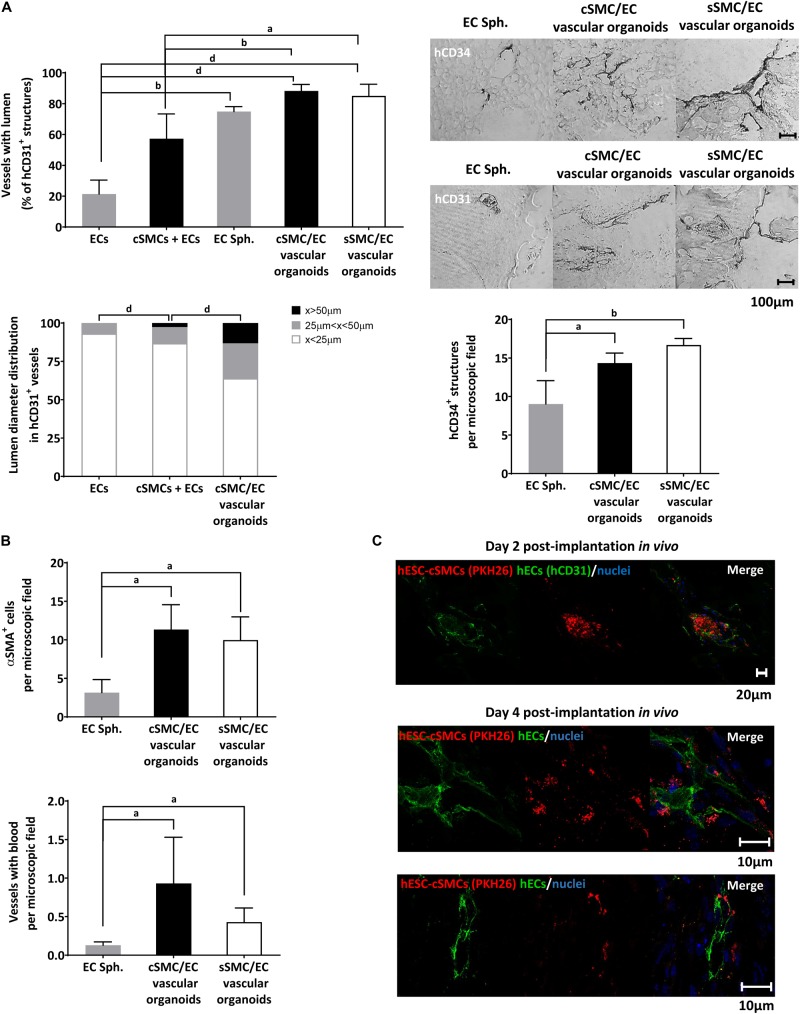
Functional characterization of vascular organoids in vivo.
(A) Chart presenting percentage of vessels of human origin (anti-hCD31 positive) with lumens in ECs, hESC-cSMCs + ECs single cell matrigel implants and in EC spheroids, hESC-cSMC/EC, hESC-sSMC/EC vascular organoid matrigel implants, 4 days after the implantation (upper). Vascular structures of human origin (anti-hCD31 positive) with lumen were quantified per microscopic field and expressed as percentage of the total anti-hCD31 positive structures. Chart presenting the lumen distribution of human vascular structures (anti-hCD31 positive) in ECs, hESC-cSMC/EC single cell matrigel implants and in hESC-cSMC/EC vascular organoid matrigel implants, 4 days after the implantation (left). Chart presenting the number of anti-hCD34 (positive structures in EC spheroid, hESC-cSMC/EC and hESC-sSMC/EC vascular organoid matrigel implants, 4 days after the implantation (right). All quantifications were performed in at least five fields and three sections per implant. All graph data are expressed as means ± SD from four animals per condition. aP < 0.05, bP < 0.01, dP < 0.001. Representative images of sections stained with anti-hCD34 antibody (upper panel) or anti-hCD31 antibody (lower panel) using immunohistochemistry in EC spheroids, hESC-cSMC/EC, and hESC-sSMC/EC vascular organoid matrigel implants (images from left to right), 4 days after the implantation. Scale bar, 100 μm. (B)
In vivo analysis of vessel maturation and perfusion. Sections from EC spheroids, hESC-cSMC/EC and hESC-sSMC/EC vascular organoid matrigel implants 4 days after implantations were stained with anti-αSMA antibody and the number of positive cells per microscopic field was quantified and presented in the upper chart. Vascular structures containing red blood cells/microscopic field in EC spheroid, hESC-cSMC/EC and hESC-sSMC/EC vascular organoid matrigel implants 4 days after implantation are presented in the lower histogram. All quantifications were performed in at least five fields and three sections per implant. All graph data are expressed as means ± SD from four animals per condition. aP < 0.05. (C) Immunofluoresence analysis of sections from ECs spheroids, hESC-cSMC/EC and hESC-sSMC/EC vascular organoid matrigel implants 2 days (upper panel) and 4 days (lower panels) after implantation. Green fluorescence indicates human ECs (anti-hCD31-FITC staining) (left images), red fluorescence indicates hESC-cSMCs or hESC-sSMCs (prelabeled with PKH26) and blue fluorescence indicates nuclei (Draq5 staining). Merged images are shown (right images). Images were taken on Leica TCS SP5 confocal microscope and are representative of 2 animals (2 days) and 4 animals (4 days). Scale bars, 10, 20 μm.)